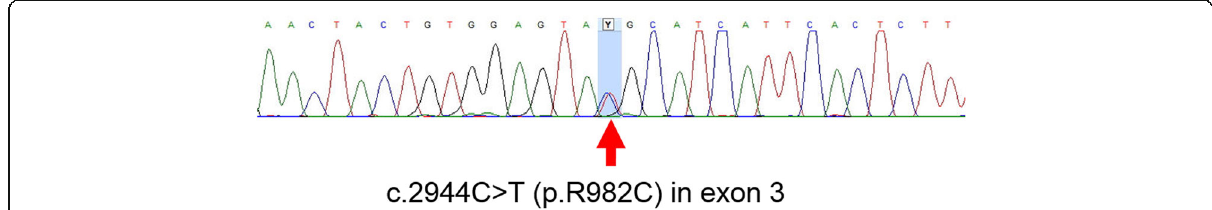
Fig. 2 Partial sequence of the SAMD9 gene. Sanger sequencing of SAMD9 identified a heterozygous mutation of c.2944C > T (p.R982C) in exon